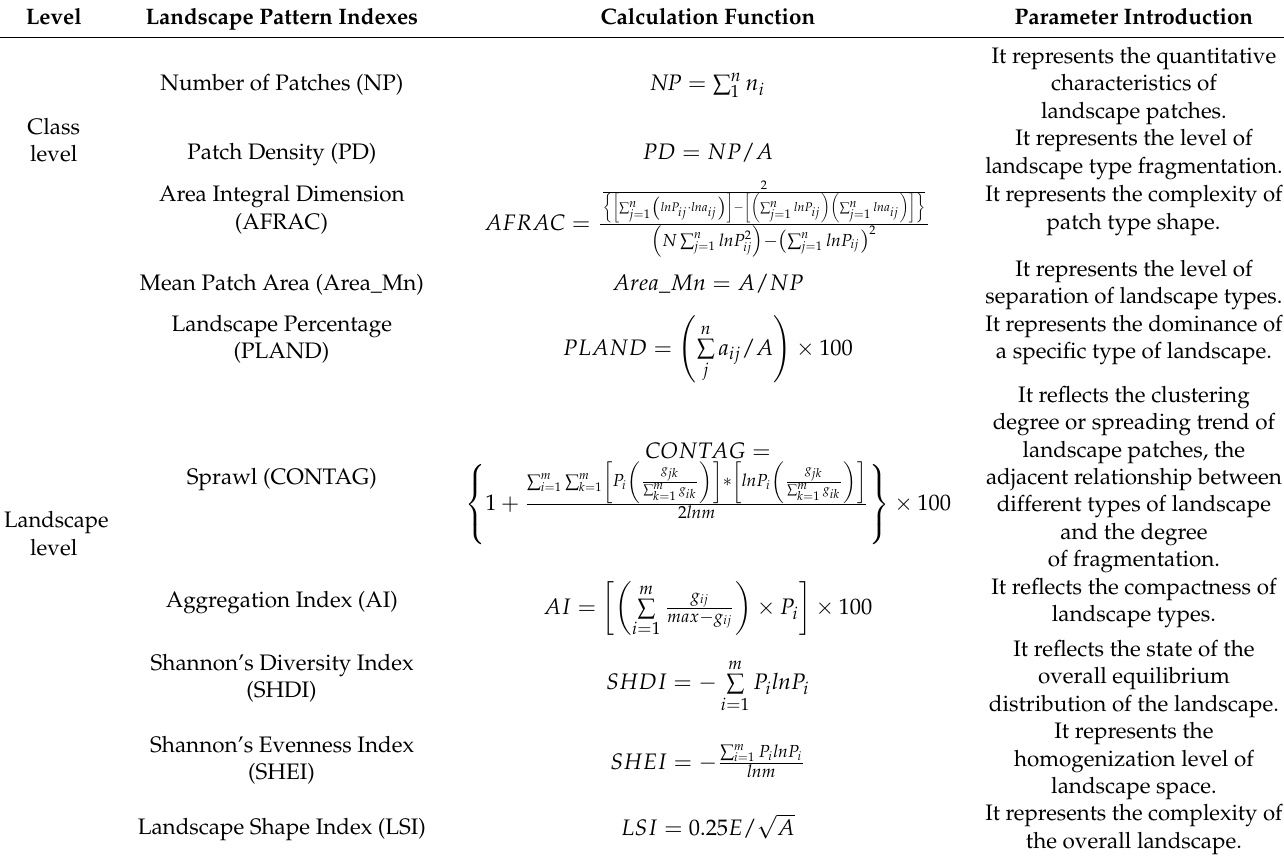
Table 3. Landscape pattern index